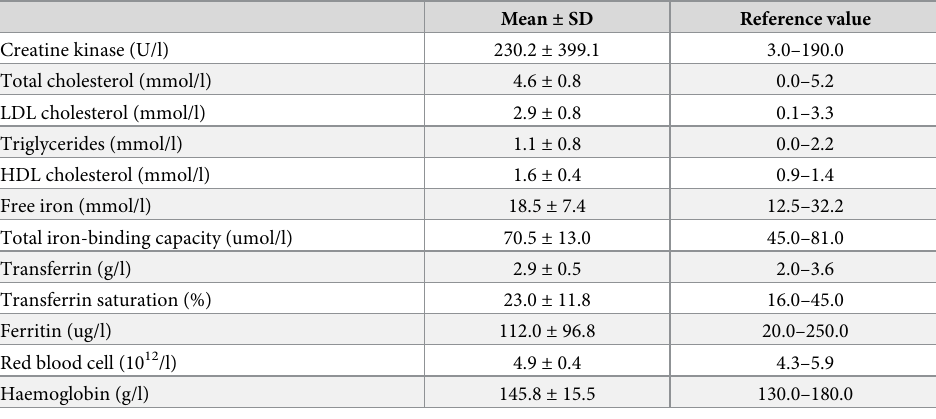
Table 2. Results of the blood